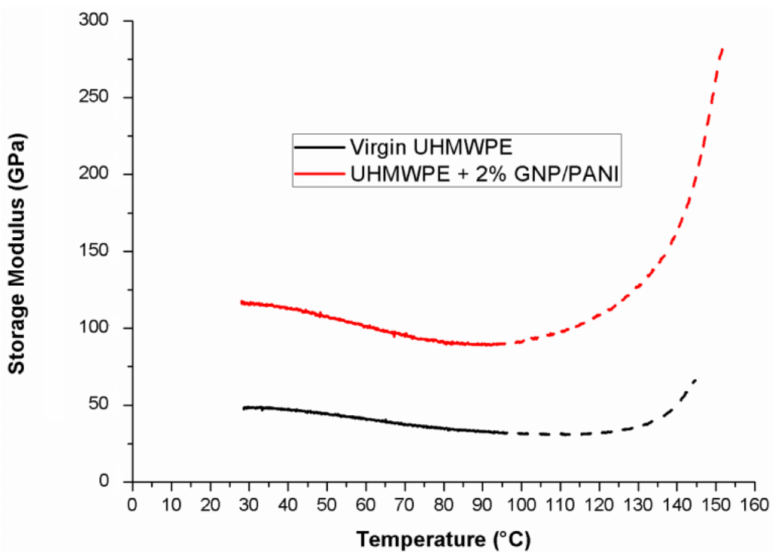
Figure 8. DMA dynamic loss modulus of the UHMWPE/GNP/PANI films.